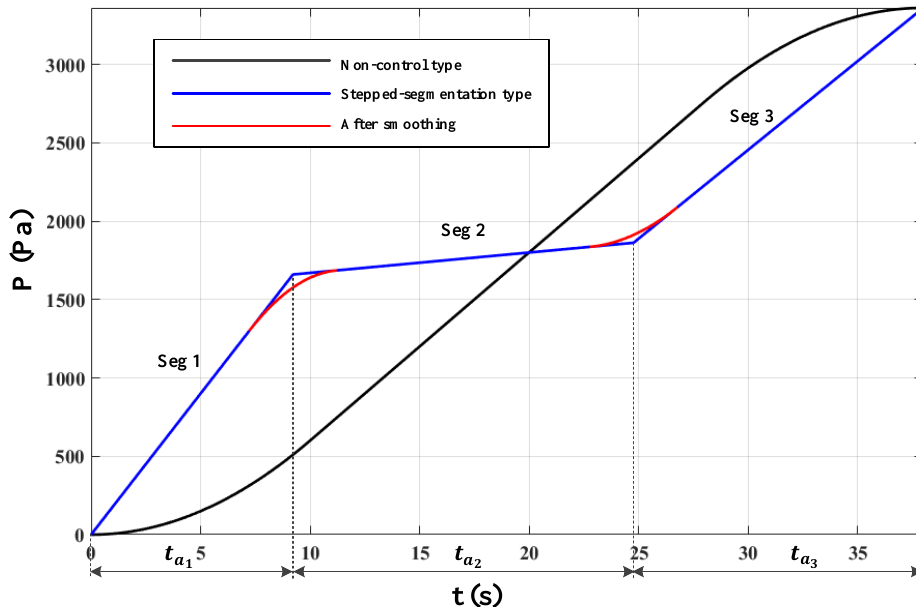
Figure 11. THEC-APC of the optimal solution. Table 4. Comparison results between the optimal stepped-segmentation curve and the non-control curve.